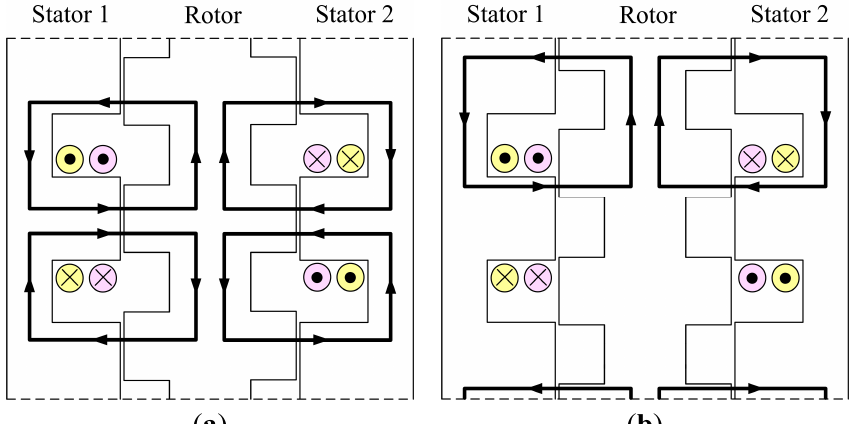
Figure 4. DC flux-linkage paths of the proposed machine: ( a ) Position 1; and ( b ) Position